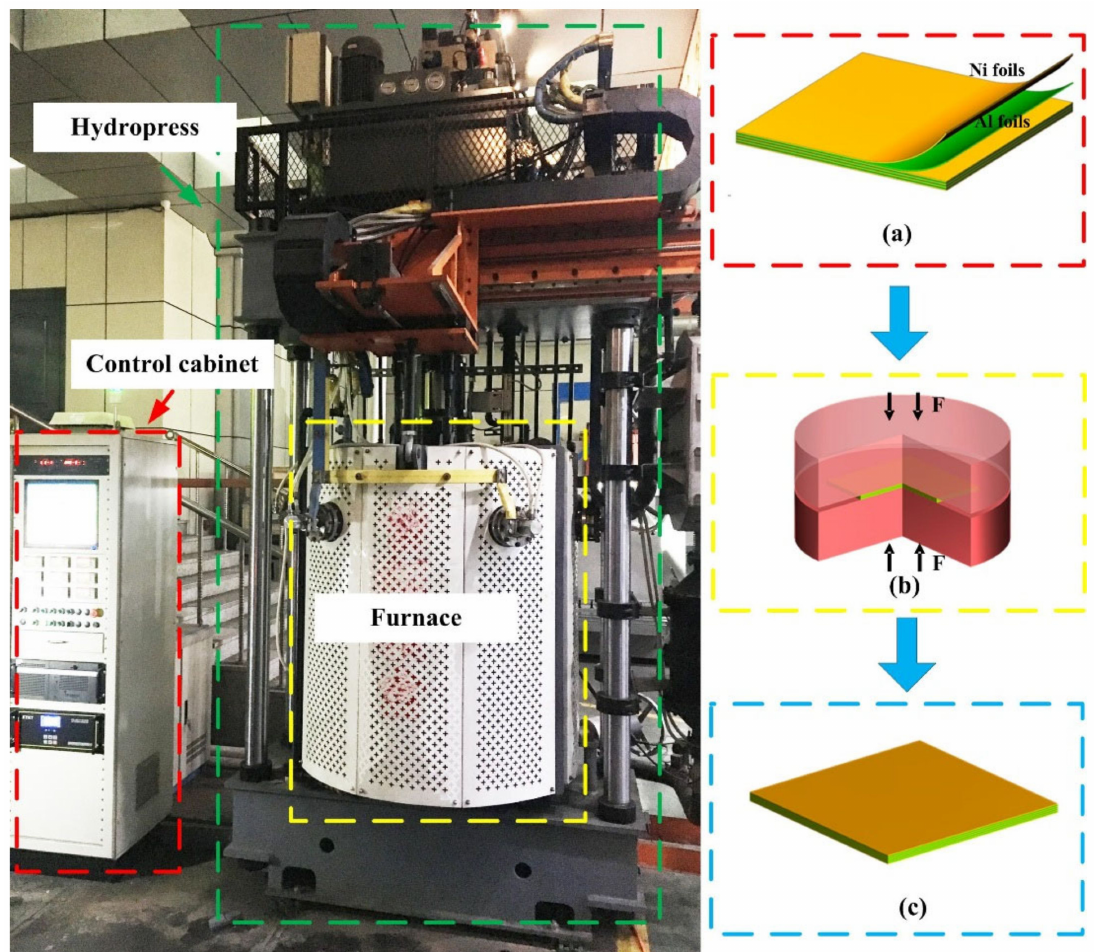
Figure 1. Schematic of the preparation procedure for the laminated composites. ( a ) Stacked alternately Ni and Al foils; ( b ) hot pressing to obtain the laminated composites; ( c ) the final laminated